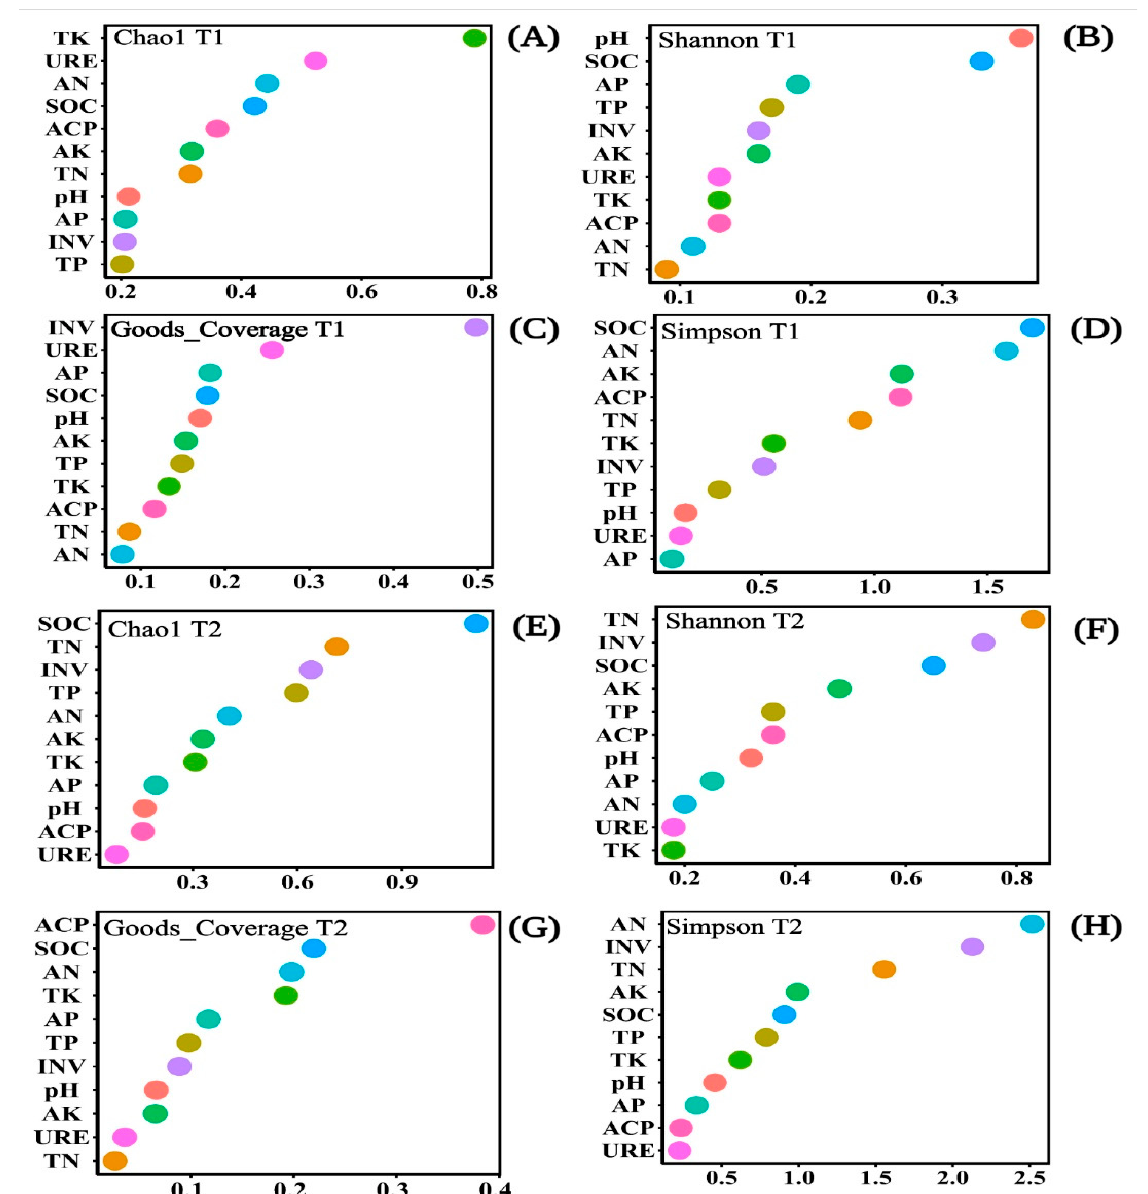
Figure 8. Scattered plots of Random Forest Modeling for the soil chemical properties and soil enzyme activities impacted on the soil bacterial communities shown by the Chao1 index ( A , E ), Shannon index ( B , F ), Goods_coverage ( C , G ), and Simpson index ( D , H ) under different emergence phases (T1 for early phase and T2 for late phase) within the riparian zones of the Three Gorges Dam Reservoir, China. The variables were ordered from top-to-bottom, as the most to the least important. Note: Abbreviations in the figure define as pH, available potassium (AK), total potassium (TK), alkali hydrolyzed nitrogen (AN), available phosphorus (AP), soil organic content (SOC), total nitrogen (TN), total phosphorus (TP), acid phosphatase (ACP), invertase (INV), and urease (URE).